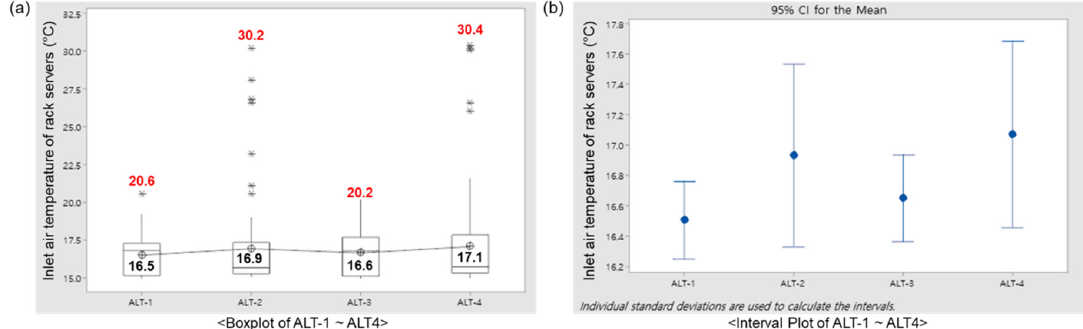
Figure 17. Inlet air temperature distribution of server racks; ( a ) boxplot and ( b ) interval plot.